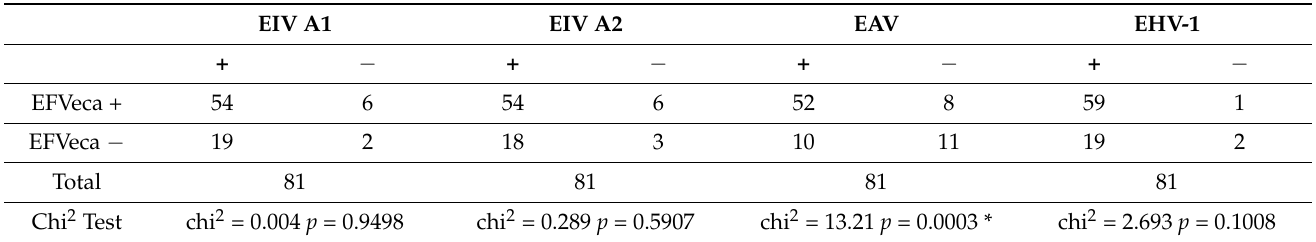
Table 4. Association between seropositivity to EFVeca and other equine viruses in tested horse samples; p -values less than 0.05 were assumed to be statistically